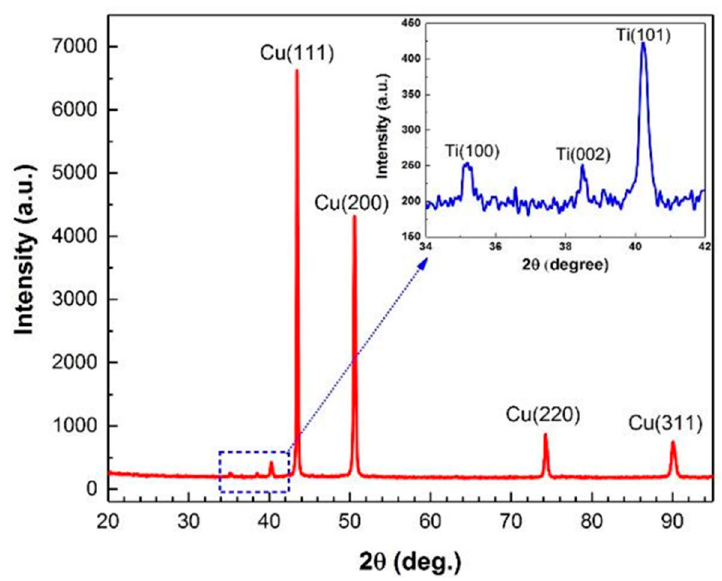
Figure 4. XRD pattern for Ti-Cu bimetal in the adjacent of weld interface.